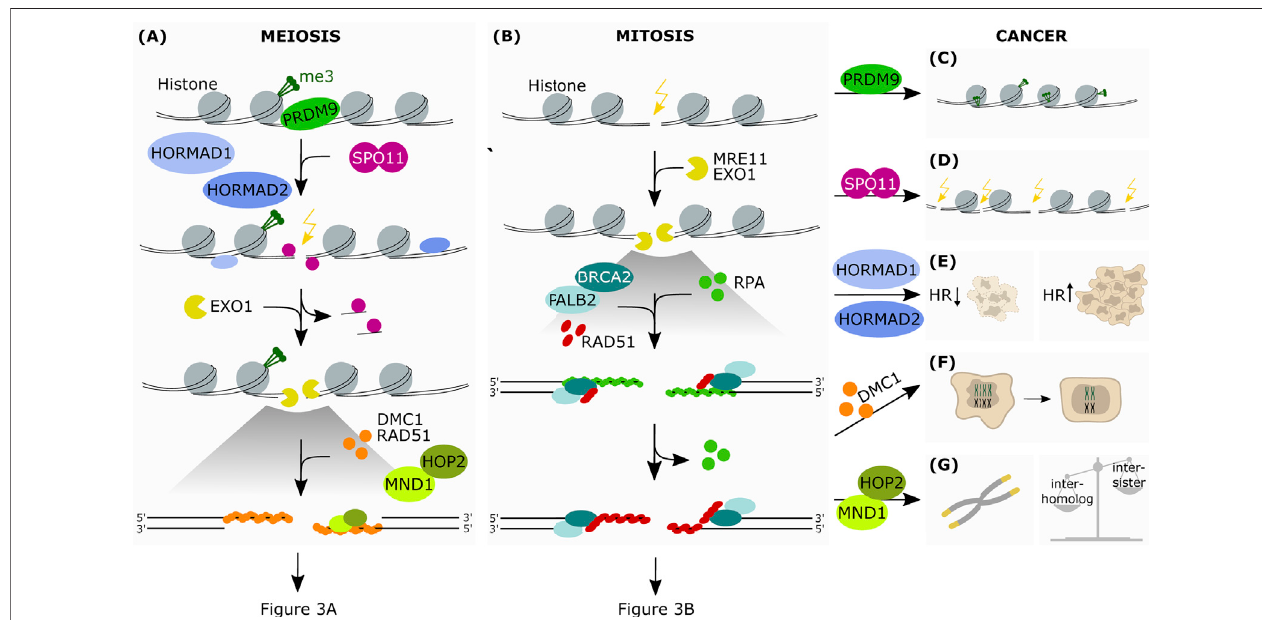
FIGURE 2 | The aberrant expression of meiotic genes in somatic cancers affects HR-dependent-DNA repair. Simpli fi ed schematic representation of the fi rst steps of HR in meiosis (A) and mitosis (B) (A) PRDM9 is the protein responsible for the epigenetic marking of the hotspots for DSB introduction. This allows the binding of SPO11, which is favoured by HORMAD1 and HORMAD2. SPO11 introduces strand breaks at the marked hotspots. This is followed by end resection at the break sites by exonucleolytic activity. The subsequent binding of the RAD51 and DMC1 recombinases onto ssDNA allows the formation of a nucleoprotein fi lament, which in turn recruits downstream factors promotinginteractionbetween homologous chromosomes. Theprotein heterodimer HOP2-MND1acts inconcertduring thisprocess favoringhomologysearchandthereforeresolutionoftheDSB (B) Uponrecognitionofthebreaksite,thenucleasesMRE11andEXO1resecttheDNAgeneratingssDNA which are stabilized by RPA. This allows the formation of the RAD51-ssDNA fi laments, in cooperation with BRCA2 and PALB2, which search for the homologous DNA template by invading the sister chromatid (C) In some cancer cells PRDM9 may also mark DNA regions that are favorable to the formation of chromosomic lesions (D) Due to its meiotic function in generating DNA strand breaks, aberrantly expressed SPO11 may then promote crossover events in somatic cancer cells, as well as translocations, insertions and deletions (E) Due to its ability in modulating HR-mediated DNA damage repair, increased expression of HORMAD in somatic cancers has beenshowntopromoteordisruptHR-mediatedrepair,dependingonthegeneticbackground (F) ExpressionofDMC1promotesmeiosis-likereductionalsegregationof homologuesinpolyploidcells,restoringtheproliferativestateofsomaticcancercells (G) HOP2-MND1mayfunctionincancercellstopromoteanalternativelengthening of telomeres (ALT) in the absence of telomerase reactivation. Furthermore, as HOP2-MND1 favor recombination between homologous chromatids in meiotic cells, their reactivation in somatic cancer cells could disrupt the recombination bias between sister chromatids that is typical of mitotic